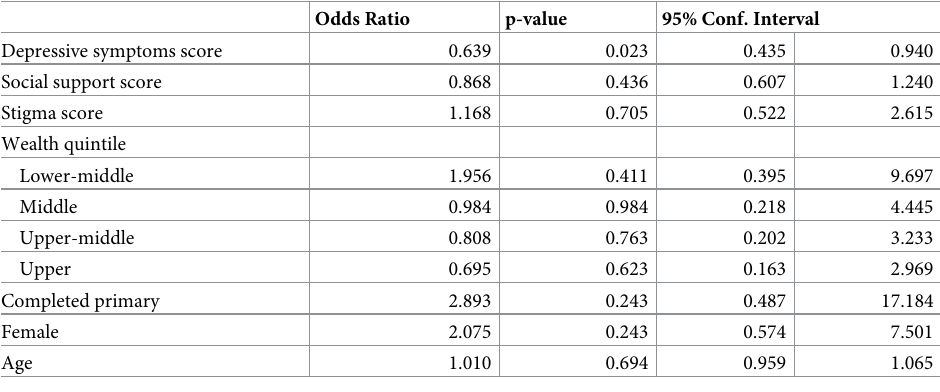
Table 5. Logistic regression predicting ART adherence among caregivers who reported testing positive for HIV and currently taking ART (n =